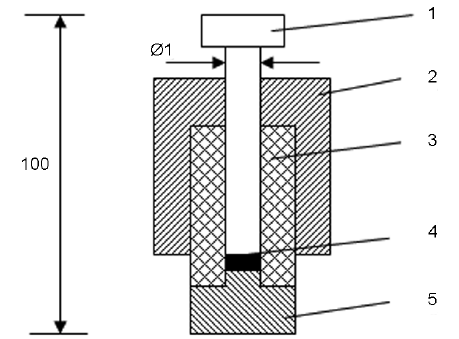
Fig. 3. Mould for char placing: 1 – plunger (HRC 55-60); 2 – guide bar; 3 – ebonite insert; 4 – char; 5 – base (HRC 55-60)